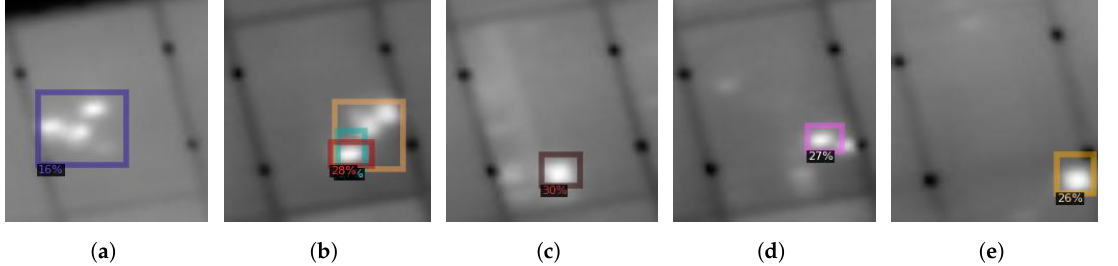
Figure 13. Five different hotspots ( a – e ) detected using our region-based CNN algorithm on the dataset acquired at Madrid,